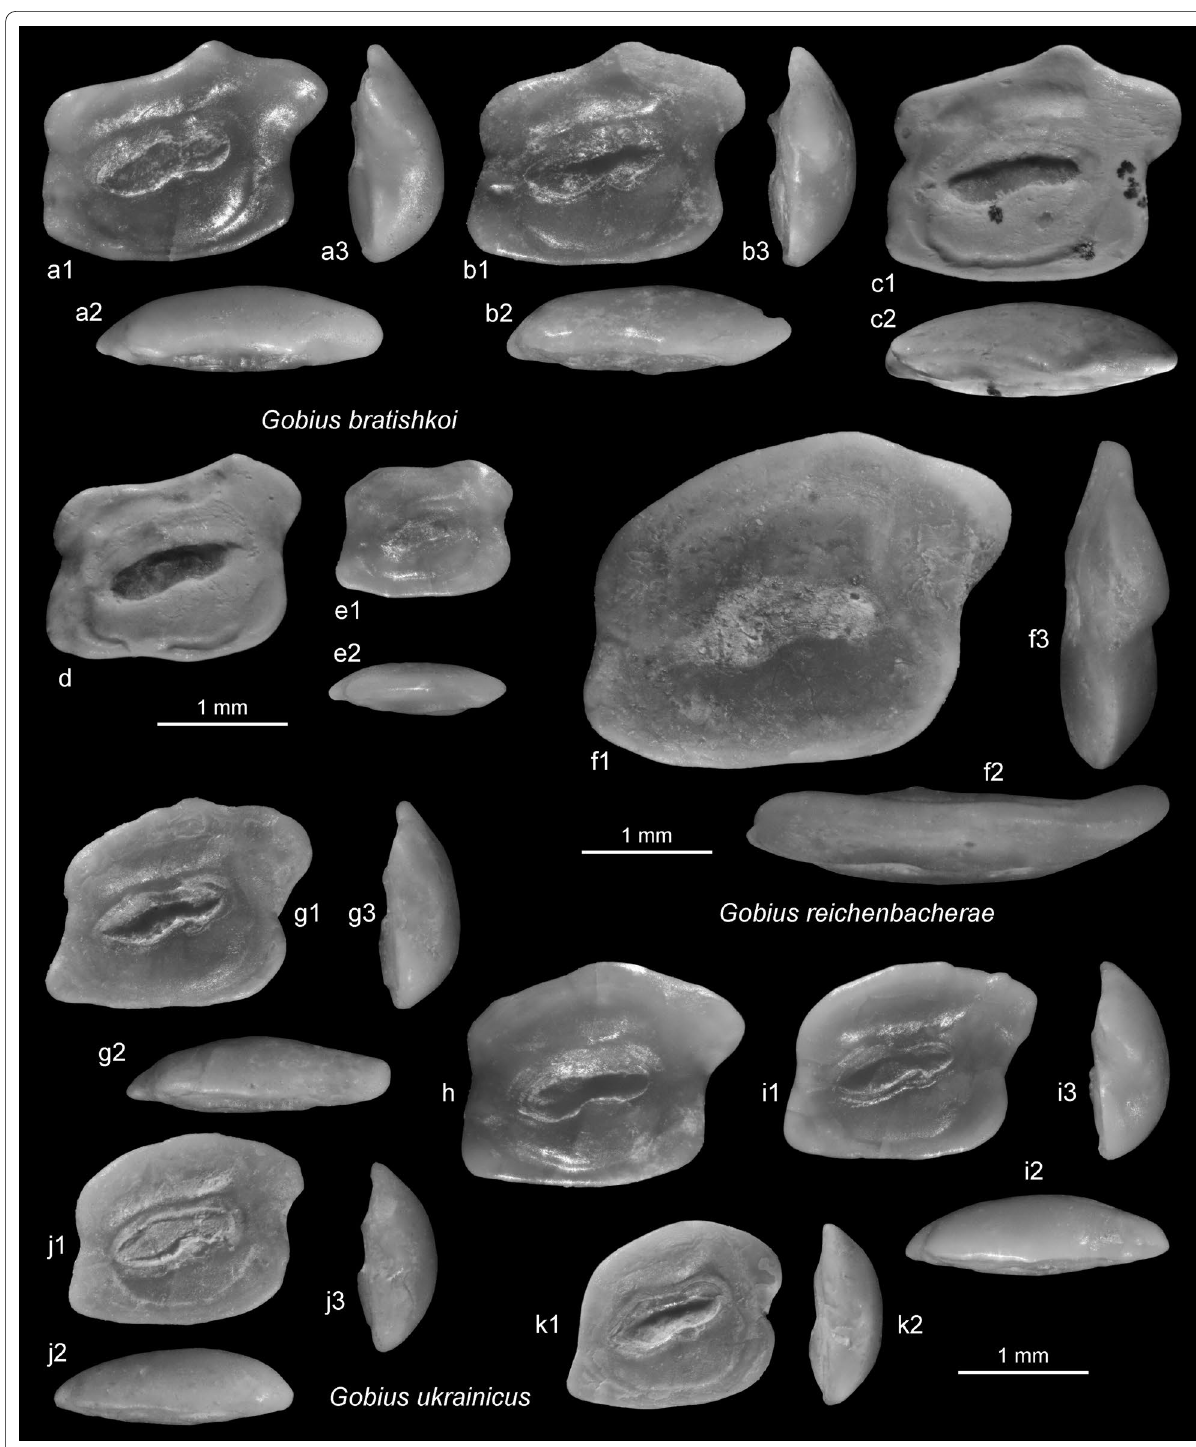
Fig. 4 Otoliths of Gobius spp.: a – e Gobius bratishkoi n. sp., a holotype, NMNHU-P PI 2555, Kozatskyi Yar, b – e paratypes, b (reversed) Mlyntsi, NMNHU-P PI 2556, c – e (reversed) Kozatskyi Yar, NMB P1211. f Gobius reichenbacherae Schwarzhans, 2014, Shydlivshchyna, NMNHU-P PI 2557 (reversed). g – k Gobius ukrainicus n. sp., j holotype, Shydlivshchyna, NMNHU-P PI 2558, g – i , k paratypes, g , i , k NMNHU-P PI 2560, h (reversed) Mlyntsi, NMNHU-P PI